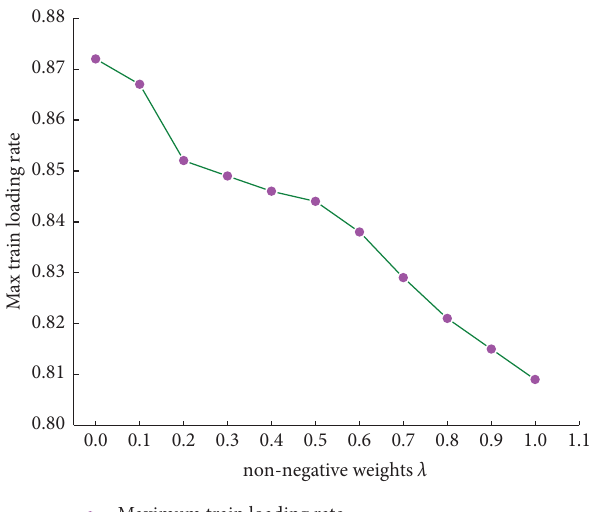
Figure 8: Maximum train loading rate under diferent weights λ